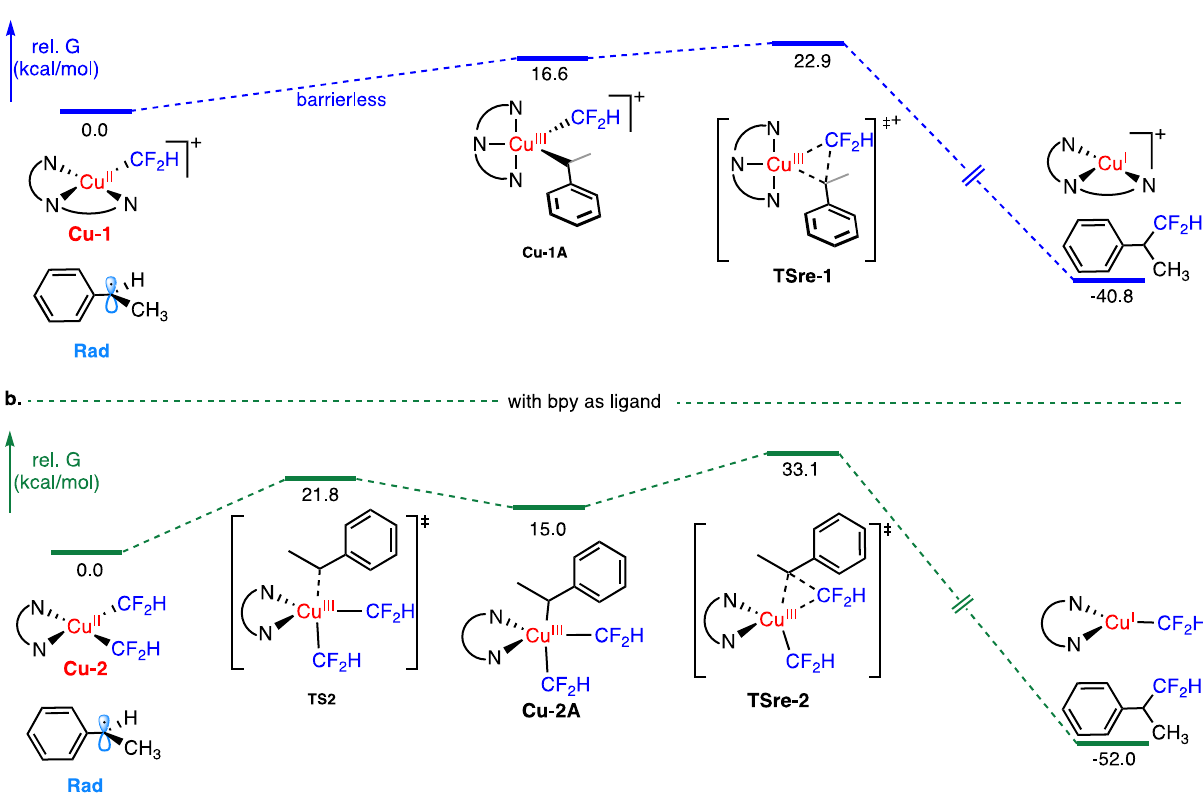
Fig. 7 Energy pro fi le of the reactions between a secondary benzylic radical with [Cu II -CF 2 H] species. a Energy pro fi le of the reactions between a secondary benzylic radical with [(terpy)Cu II (CF 2 H)] species, b Energy pro fi le of the reactions between a secondary benzylic radical with [(bpy)Cu II (CF 2 H) 2 ] species. Rad, benzylic radical; terpy, 2,2 ʹ ;6 ʹ ,2 ʺ -terpyridine; bpy, 2,2 ʹ -bipyridine; TS, transition state; TSre, transition state for reductive elimination; rel. G, relative Gibbs free